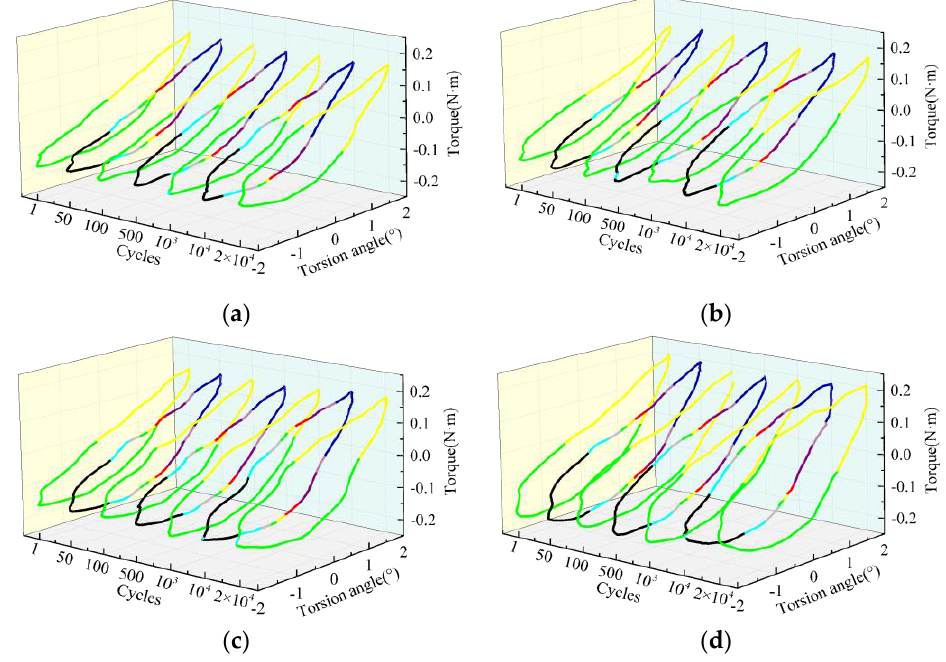
Figure 9. Evolutions of torque versus torsion angle during tension–torsion cyclic loading